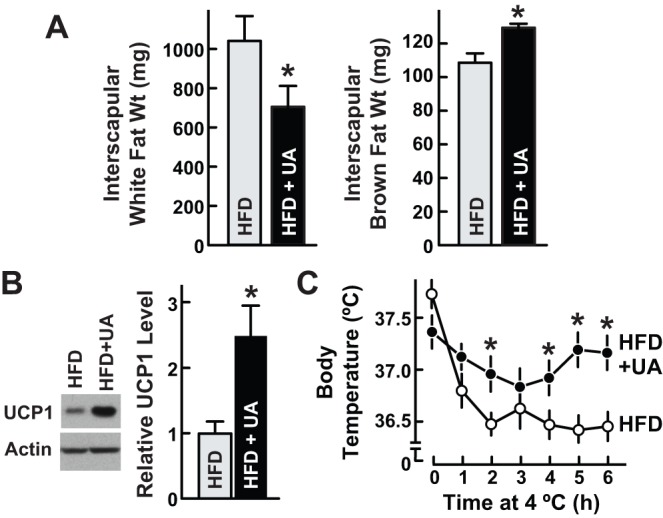
Ursolic acid increases interscapular brown fat.Mice were provided ad libitum access to high fat diet (HFD) lacking or containing 0.14% ursolic acid (UA) for 6 weeks. Data are means ± SEM. *P<0.05 by t-test. (A) Interscapular fat pads were harvested and dissected into white fat and brown fat components, which were then weighed. n = 10 mice per diet. (B) Protein from the entire interscapular fat pad was isolated and subjected to SDS-PAGE and immunoblot analysis with anti-UCP1 and anti-actin antibodies. Upper: representative immunoblots. Lower: UCP1 and actin levels were quantitated with densitometry. In each mouse, the UCP1/actin ratio was normalized to the average UCP1/actin ratio in mice fed HFD lacking UA, which was set at 1. n = 8 mice per diet. (C) Cold tolerance test. Following 6 weeks of HFD ± UA, a baseline rectal temperature was obtained at 21°C (t = 0 hours). Mice were then moved to 4°C, where rectal temperature was measured hourly. n = 8 mice per diet.